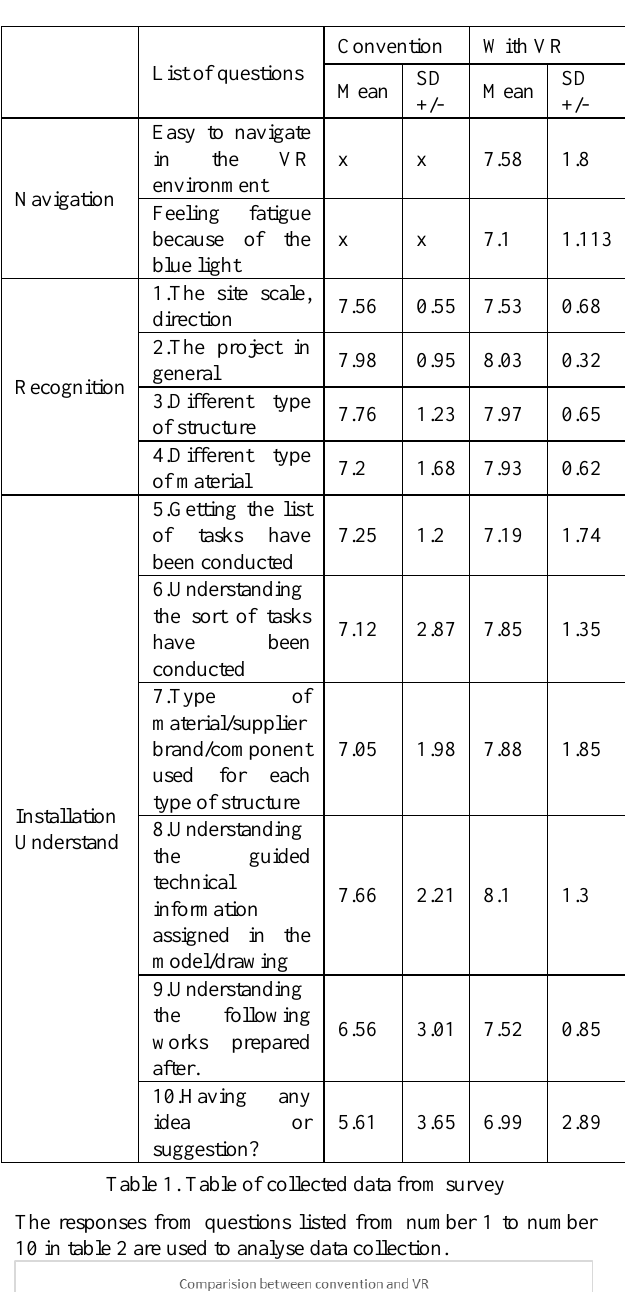
Fig. 7. Comparison from each response for each division in table